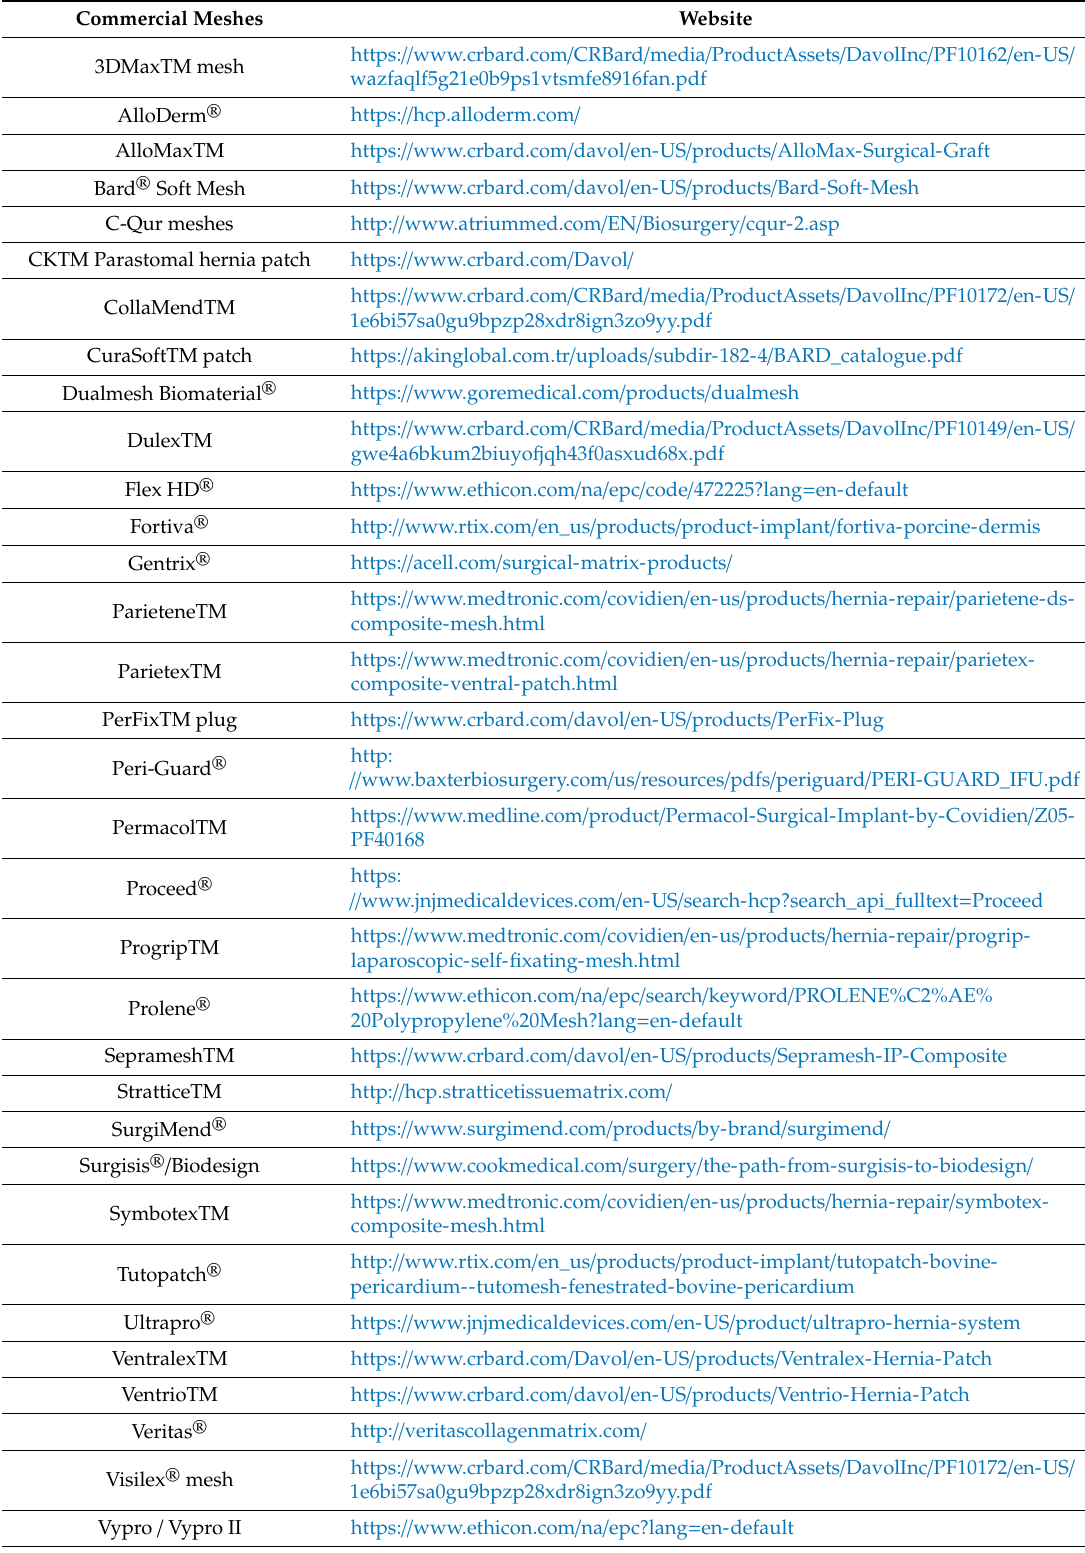
Table 3. Web site listing of cited commercial